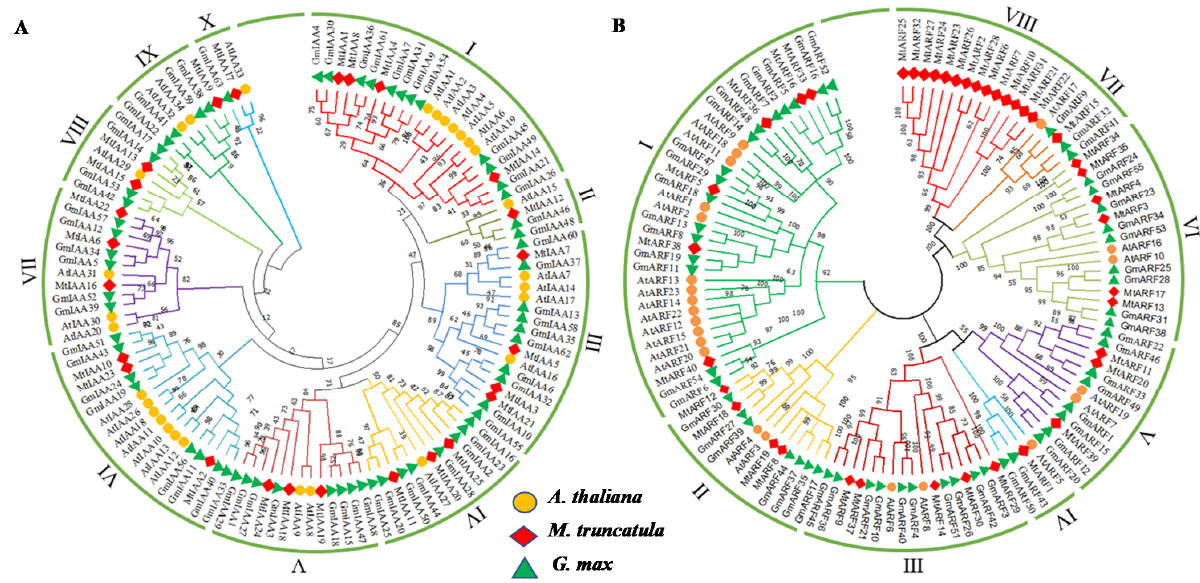
Figure 1. Phylogenetic trees of IAA ( A ) and ARF ( B ) proteins among M. truncatula , Arabidopsis thaliana and soybean. The tree was constructed with 1000 bootstrap replications. IAAs and ARFs from A. thaliana , M. truncatula and soybean were indicated using orange, red and green colors, respectively, for distinguishing them.